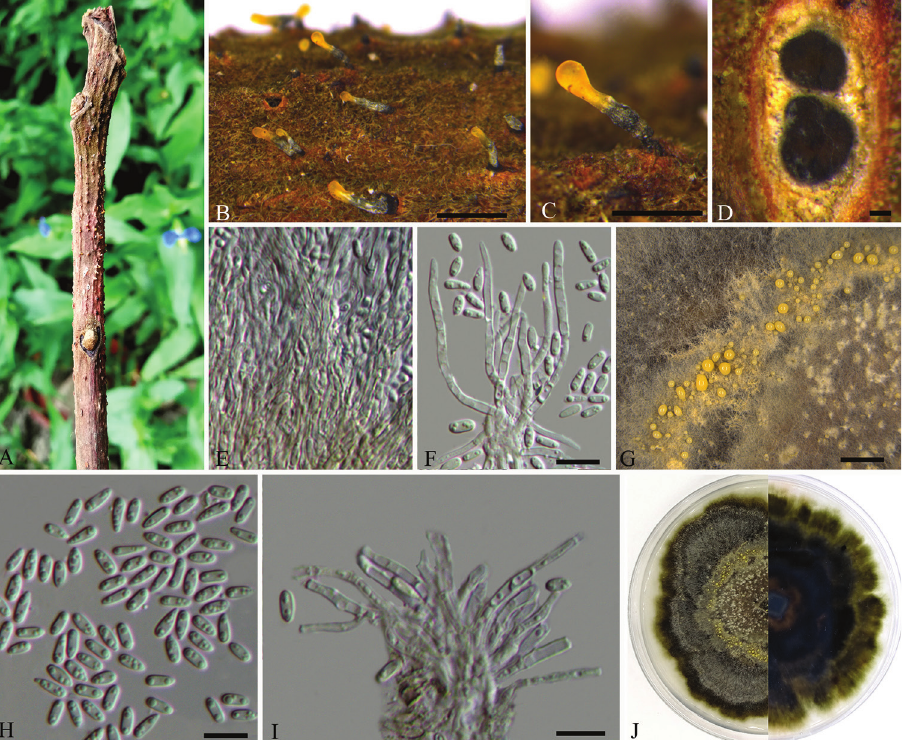
Figure 2. Flavignomonia rhoigena on Rhus chinensis (BJFC-S1766, holotype) A–C habit of conidiomata on twigs D transverse section through synnema E longitudinal section through synnema F, I conidiog- enous cells attached with conidia G conidiomata on PDA H condia J the colony on PDA. Scale bars: 1 mm ( B ); 500 µm ( C ); 100 µm ( D ); 10 µm ( F, H–I ); 200 µm ( G